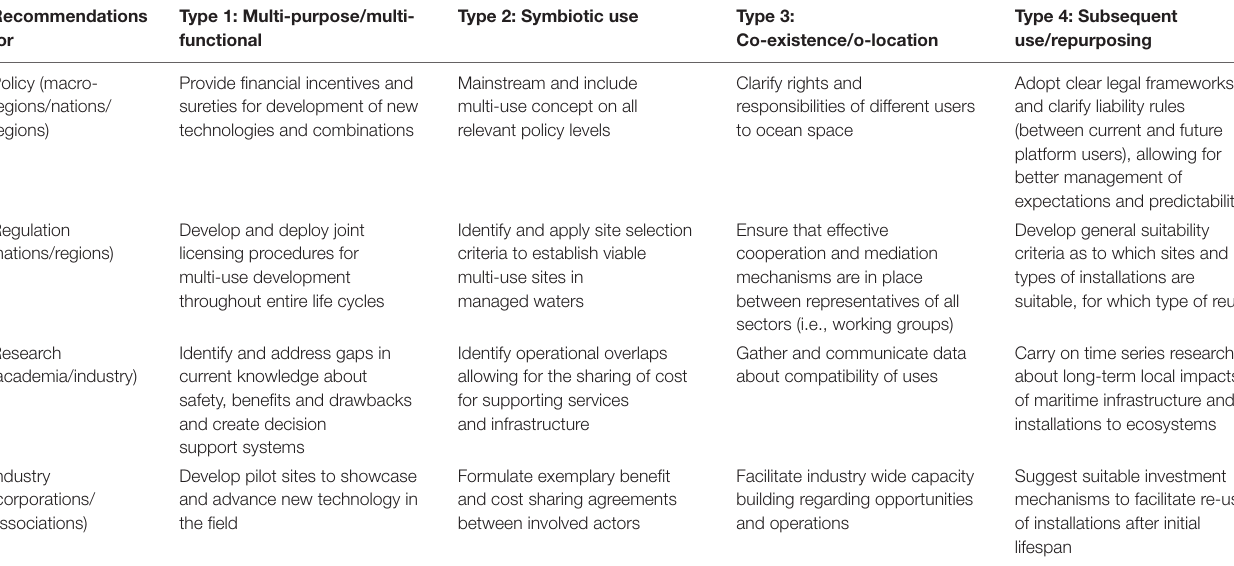
TABLE 2 | Key recommendations for each identified type of ocean multi-use pertaining to Actors from: Policy; Regulation; Research; Industry. Recommendations